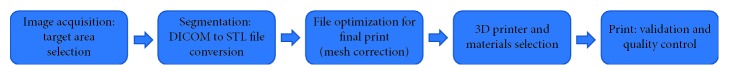
3D-printing workflow.